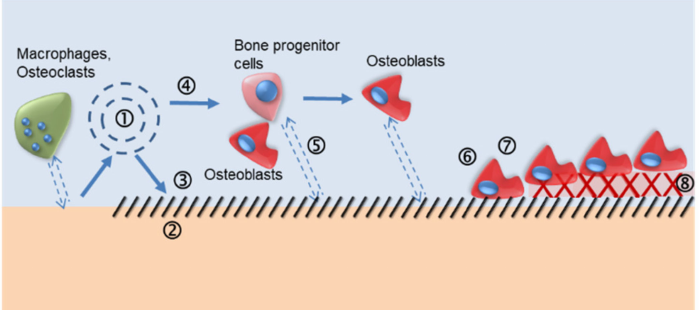
Figure 1. Scheme of bioactive materials’ ability to bond bone tissue. ( 1 ) Dissolution/precipitation pro- cesses: (passive or cell-mediated)/protein adsorption; ( 2 ) formation of a biological HA layer; ( 3 ) ionic interactions and new organization at the bioactive surface with the bone tissue interface; ( 4 ) solution- mediated effects on cellular activity; ( 5 ) chemotaxis to the biomaterial surface; ( 6 ) cell adhesion and cell proliferation; ( 7 ) cell differentiation; and ( 8 ) formation and growth of the extracellular